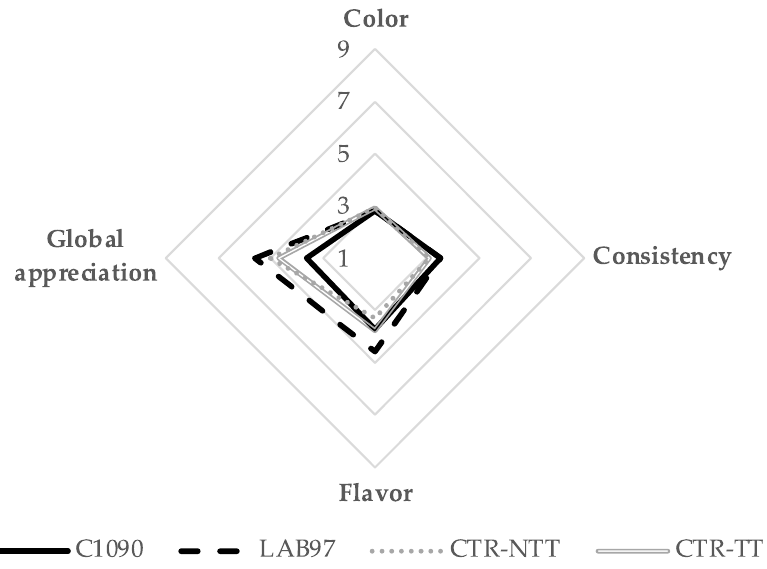
Figure 6. The average scores for the sensory attributes (colour, consistency, flavour, and global appreciation) of all the samples (LAB 97, C1090, CTR-NTT, and CTR-TT) on the 14th day.